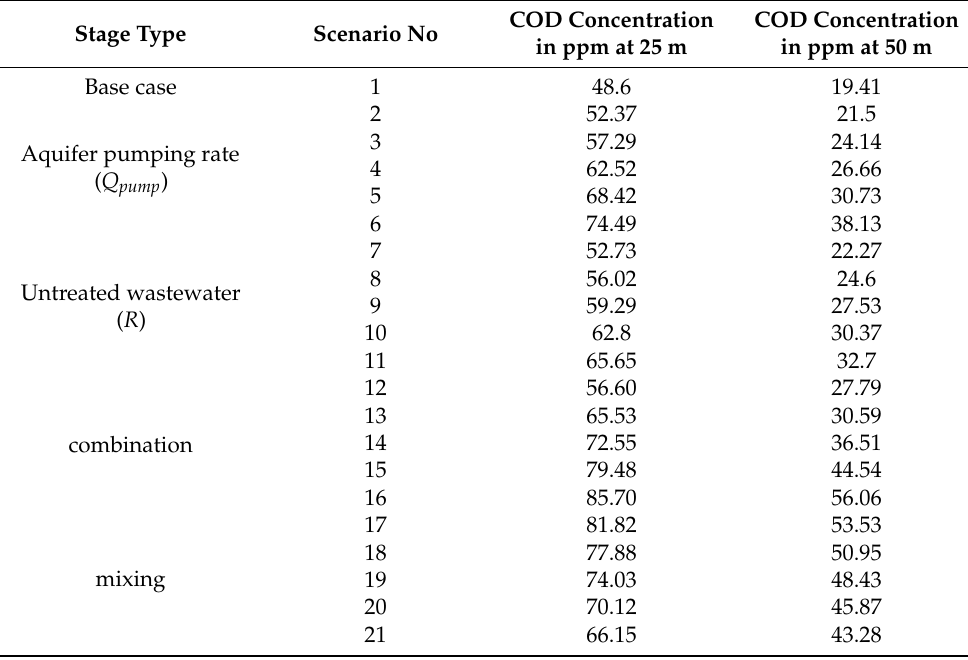
Table 3. Results of COD concentration at 25 and 50 m depths for different